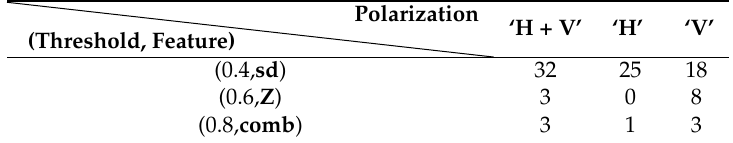
Table 7. Number of misclassified images in various conditions, for a set of 432 images in total. (Threshold,